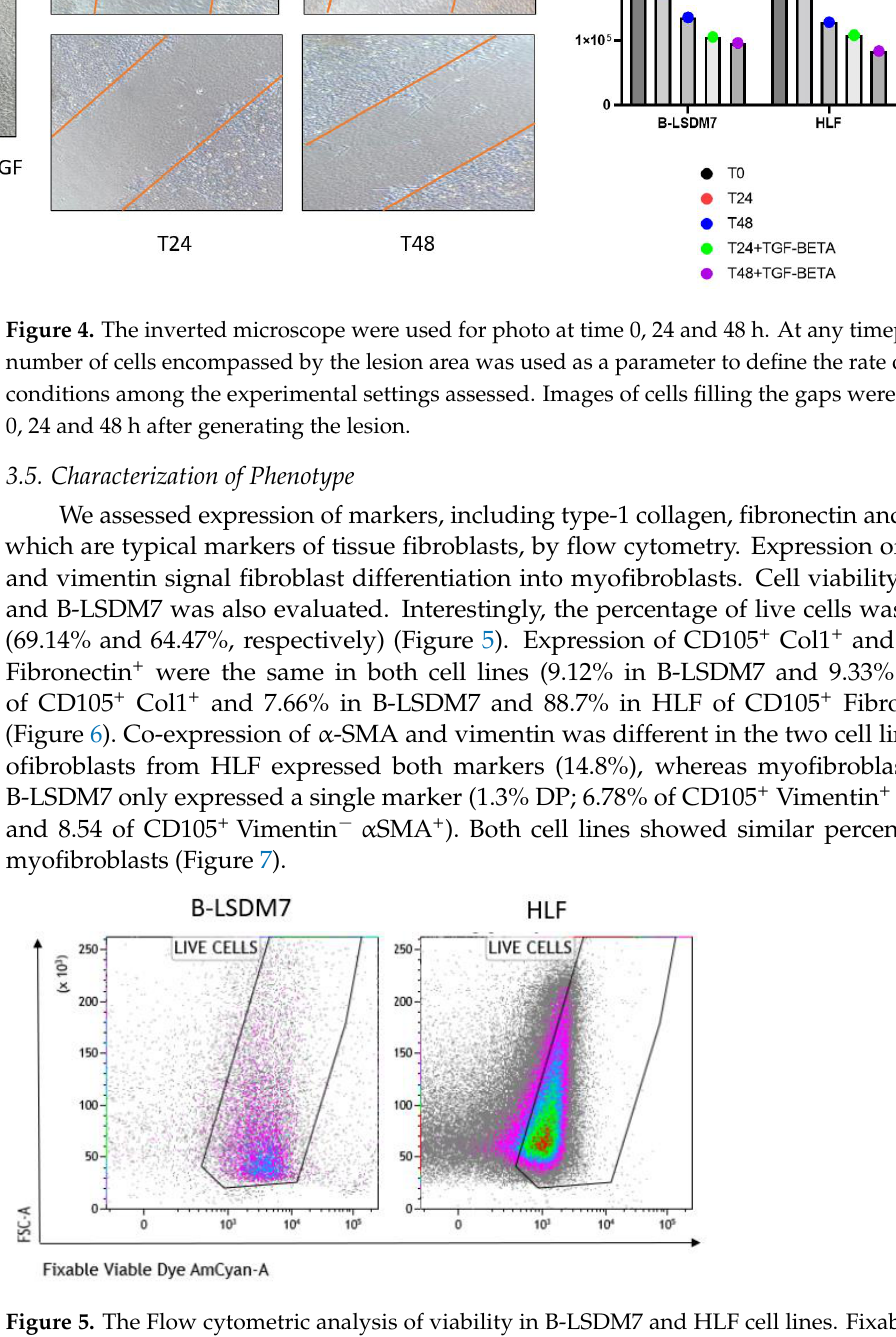
Figure 6. The Flow cytometric analysis of CD105, Fibronectin and Collagen Type 1 in B-LSDM7, HLF, FBM and RPMI cell lines.